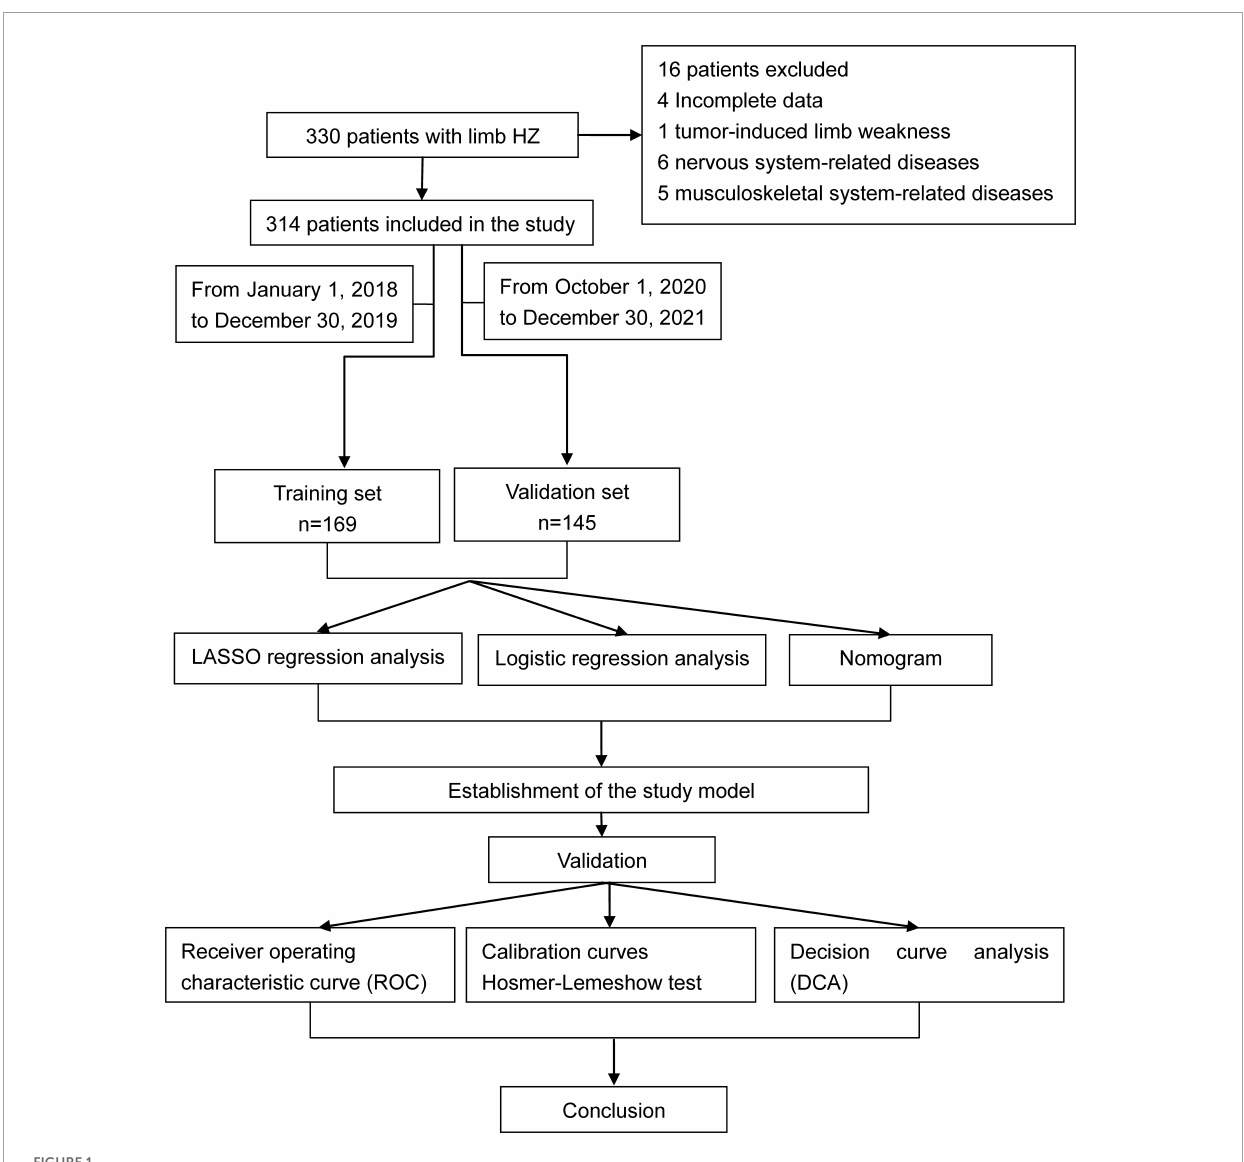
FIGURE1 Flowchart of the